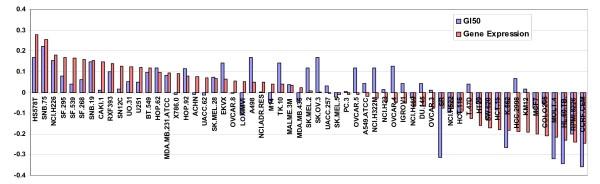
Comparison of mesenchymal-like components between the compound sensitivity and gene expression data sets. Principle component analysis revealed a shared feature in each data set. The second component of the gene expression data, containing 8.4% of the variance, was largely defined by a panel of cell lines identified previously as potentially related to mesenchymal differentiation. The 'mesenchymal' component also appeared to be a significant features of the GI50 data, the cell lines ordered here as in the plot of the gene expression data, though this component explained only 0.9% of the variance. The two 'mesenchymal' components of the gene expression and drug data correlate with each other with an R of 0.62, and therefore represent a strong but readily identifiable correlation. Thus identified, correlations with similarities to these patterns can be noted and subtracted or filtered from analyses.